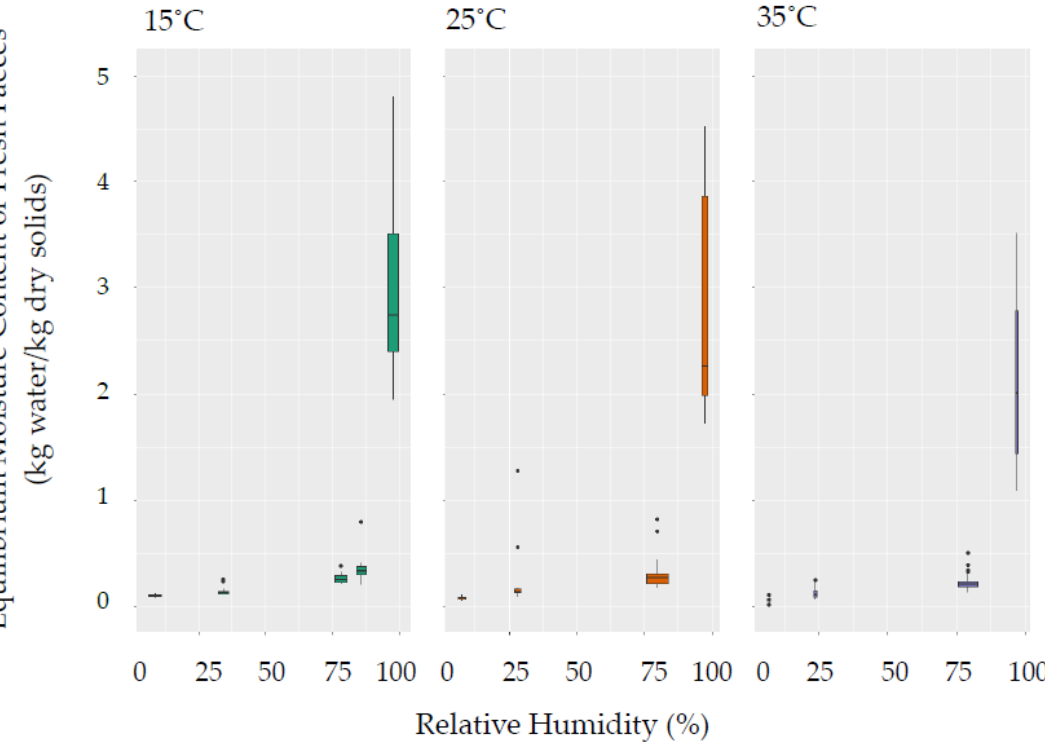
Figure 2. Box plots of equilibrium moisture content data at temperatures of 15, 25 and 35 °C with a